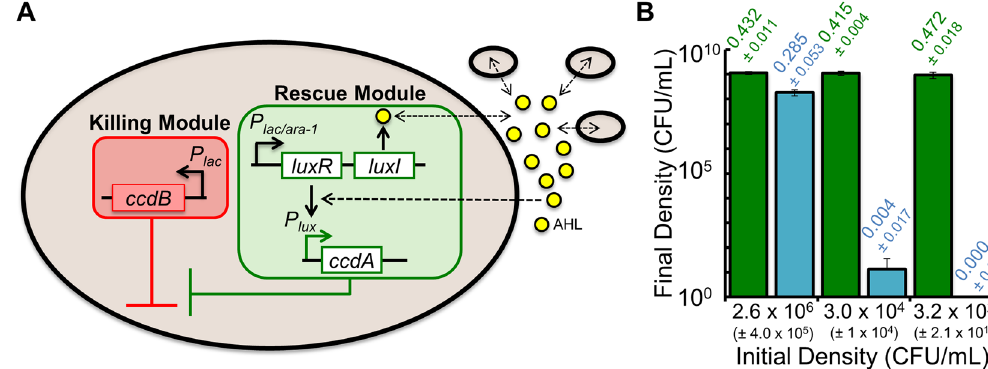
Figure 1. The engineered bacteria used in this study. ( A ) The gene circuit consists of two modules: a killing module (red shading) and a rescue module (green shading). The killing module contains an IPTG inducible ( P lac promoter) ccdB gene from the CcdA/CcdB toxin-antitoxin system. The rescue module contains an IPTG inducible ( P lac / ara - 1 promoter) luxR / luxI quorum-sensing (QS) system from Vibrio fischeri 8 and an AHL inducible ( P lux promoter) ccdA from the CcdA/CcdB toxin-antitoxin system. Induction with IPTG (1 mM) causes expression of luxR / luxI and ccdB . ccdB causes cell death 44 . However, ccdA can inhibit ccdB if luxI synthesizes a sufficient amount of AHL (yellow circles), which is dependent upon the initial density of bacteria in the population. ( B ) Final density of engineered bacteria (CFU/mL) in cultures incubated for 48 hours starting from different initial densities (see Methods for details) Green bars = no IPTG, circuit off. Blue bars = IPTG, circuit on. An OD 600 of 0 indicates that no CFUs were detectable in the medium. Standard deviation (SD) from a minimum of three biological